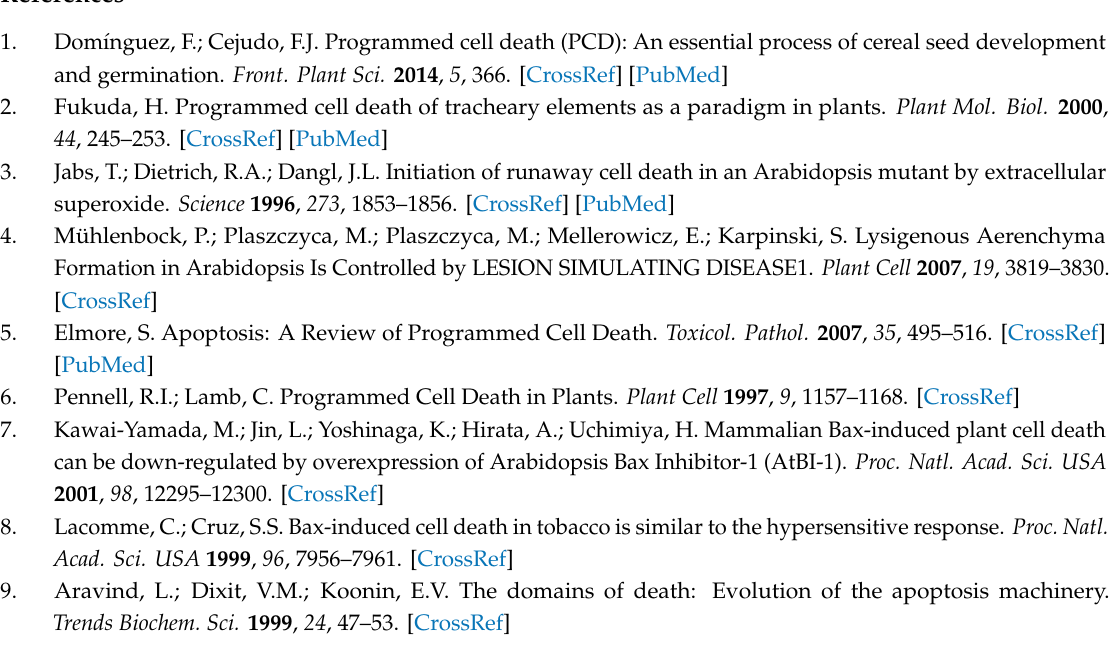
Supplementary Figure 1. The relative expression level of (A) EDS1 and (B) Bax in plants used in this study: within a subgraph, values sharing common labels (letters) are not significantly di ff erent from each other ( p > 0.001) ( n = 9). Supplementary Figure 2. Phenotype of the wildtype, eds1 mutant, and Bax and eds1 / Bax lines ( + mock /+ DEX). Supplementary Figure 3 . Relative expression level of specific singlet oxygen ( 1 O 2 ) marker genes in the wildtype, eds1 mutant, and Bax and eds1 / Bax lines for (A) BAP1 and (B) AAA-ATPase1 : within a subgraph, values sharing common labels (letters) are not significantly di ff erent from each other ( p > 0.001) ( n = 9). Supplementary Figure 4. Relative expression level of hypersensitive response (HR) marker genes in the wildtype, eds1 mutant, and Bax and eds1 / Bax lines for (A) NHL8 and (B) SAG101 : within a subgraph, values sharing common labels (letters) are not significantly di ff erent from each other ( p > 0.001) ( n = 9). Supplementary Figure 5. The relative expression level of (A) MC1 and (B) MC2 : within a subgraph, values sharing common labels (letters) are not